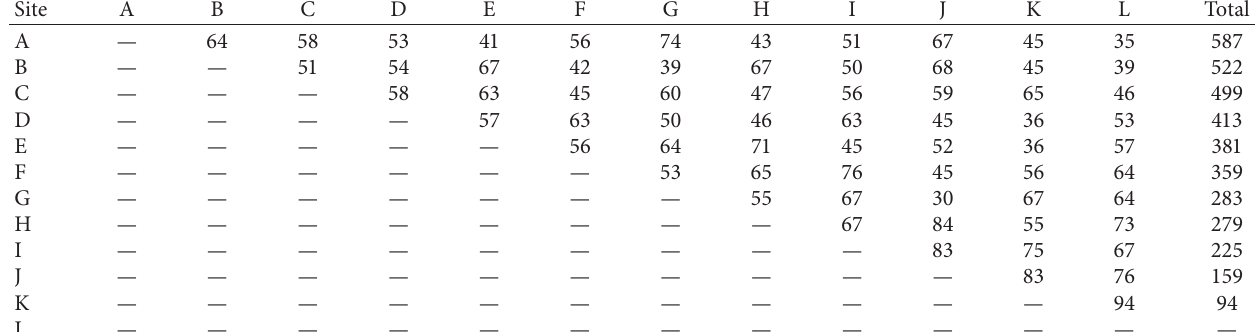
Table 6: Passenger drop-off matrix between stations.